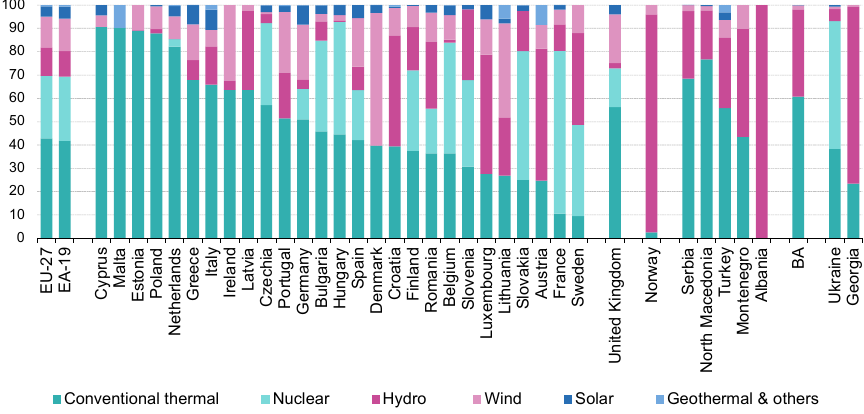
Figure 1. Energy production in the EU countries in 2019 (%). Source: Eurostat.